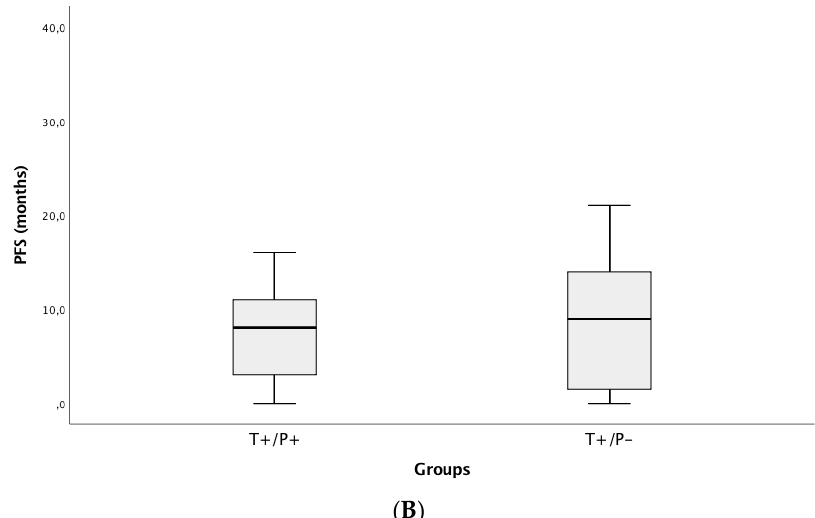
Figure 3. OS ( A ) and PFS ( B ) in tissue and plasma NGS positive and negative patients ’ samples. Patients with mutations detected in both tissue (T+) and plasma (P+) present lower OS and PFS than those without mutations detected in plasma (P − ) but present in tissue samples (T+/P − ). PFS, progression-free survival to the first-line treatment; OS, overall survival. T, tissue; P, plasma.